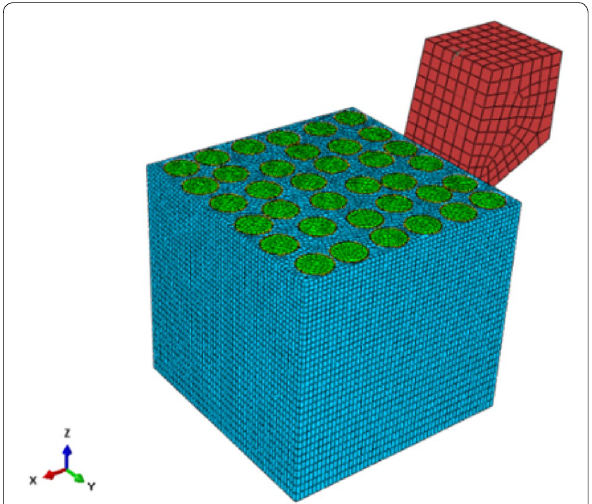
Figure 5 Micro cutting model of carbon fiber/cyanate ester